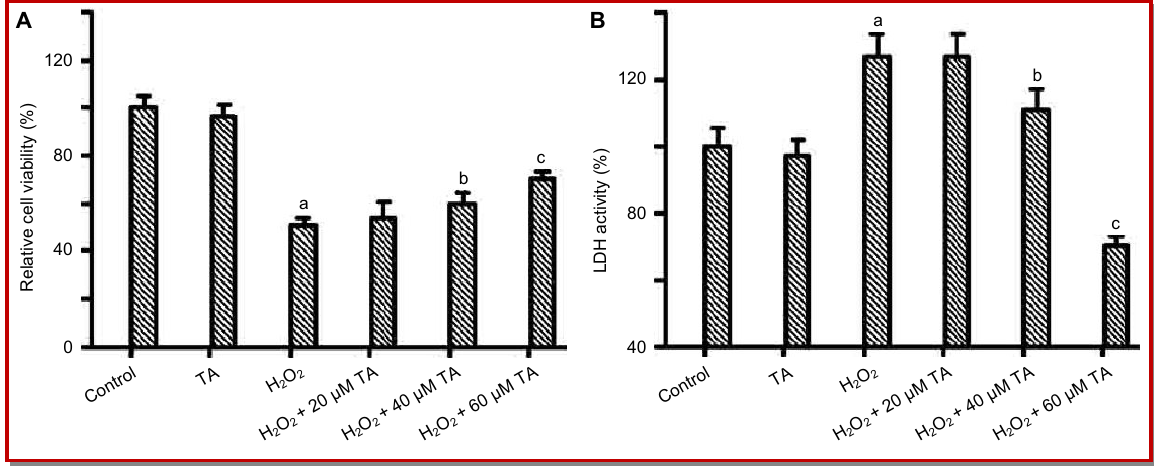
Figure 2: Taraxerol protects L02 cells against H 2 O 2 -induced cell injury. L02 cells were pretreated with or without 40 μ M taraxerol for 1 hour, followed by 0.4 mM H 2 O 2 treatment for 12 hours. A) Cell viability was measured by MTT analysis, B) LDH release was measured. TA: taraxerol. Data are expressed as mean ± SD (n = 6); a p<0.01 compared with control; b p<0.05, c p<0.01 compared with the group of H 2 O 2 -treated L02 cells